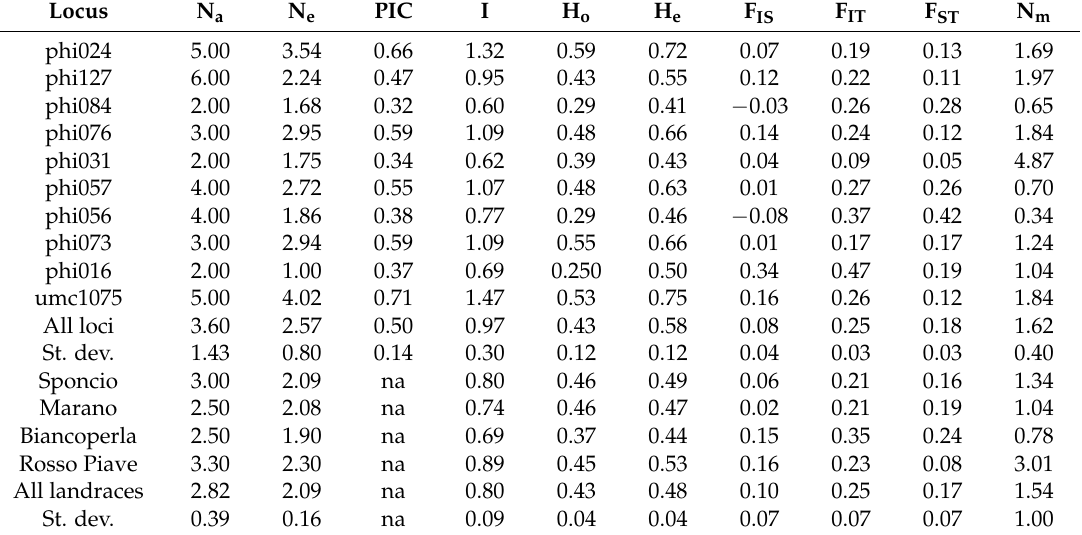
Table 2. Genetic parameters with respect to the SSR markers and to the four landraces object of this study. Average number of observed alleles (N a ), effective number of alleles (N e ) per locus, polymorphism information content (PIC), estimates of Shannon’s information index of genetic diversity (I), observed heterozygosity (H o ) and unbiased Nei’s genetic diversity equivalent to the expected heterozygosity (H e ) are shown. Wright’s inbreeding coefficients F IS , F IT and F ST and gene flow (N m ) estimates are also